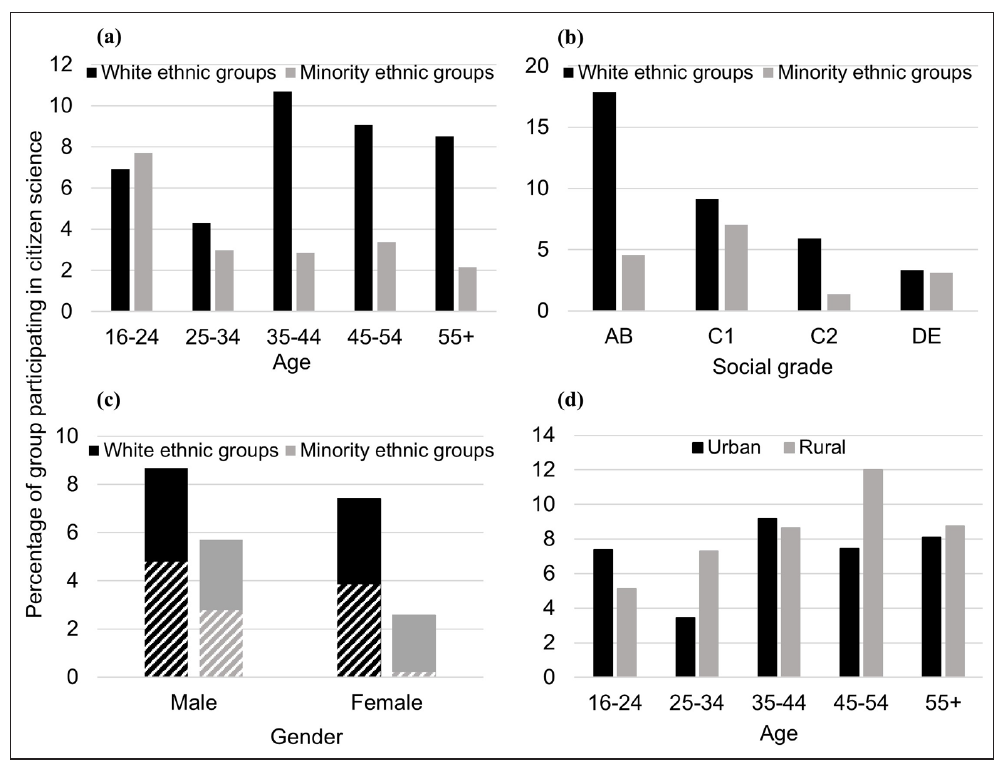
Figure 2 Interactions between participant characteristics on likelihood of citizen science participation. In each case, figures show the percentage of interviewees in each group who had participated in citizen science. Interactions are between (a) ethnicity and age, (b) ethnicity and social grade, (c) ethnicity and gender, and (d) area and age. In (c), the hatched areas show the percentage of the group that had participated in citizen science more than